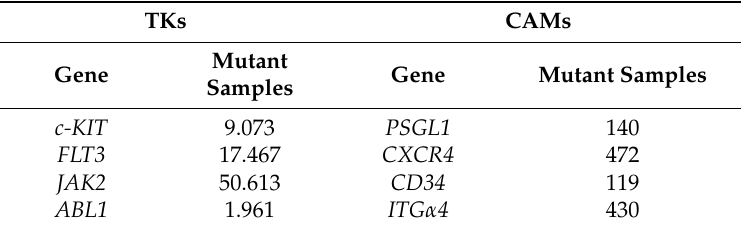
Table 1. Detected somatic mutations of selected tyrosine kinases (TKs) and cell adhesion molecules (CAMs) typically expressed in hematopoietic stem and progenitor cells. The depicted genes were analyzed using the COSMIC database software